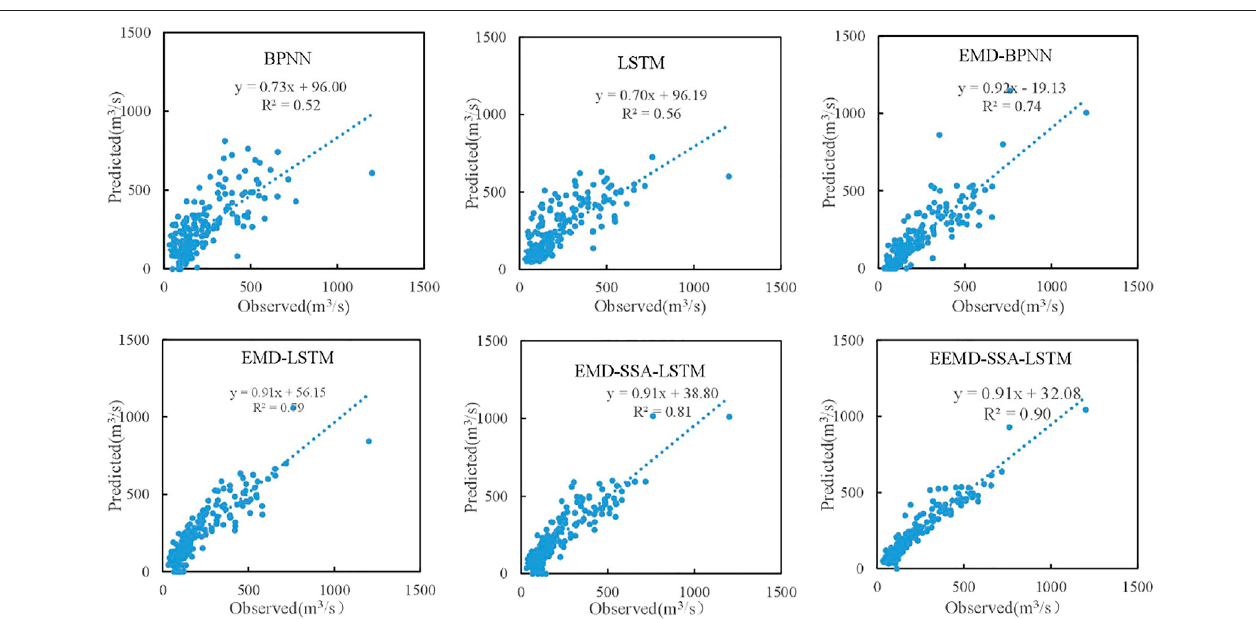
FIGURE 6 | Comparison of scatter diagrams of forecast results for the Guangzhao Reservoir during the validation period.